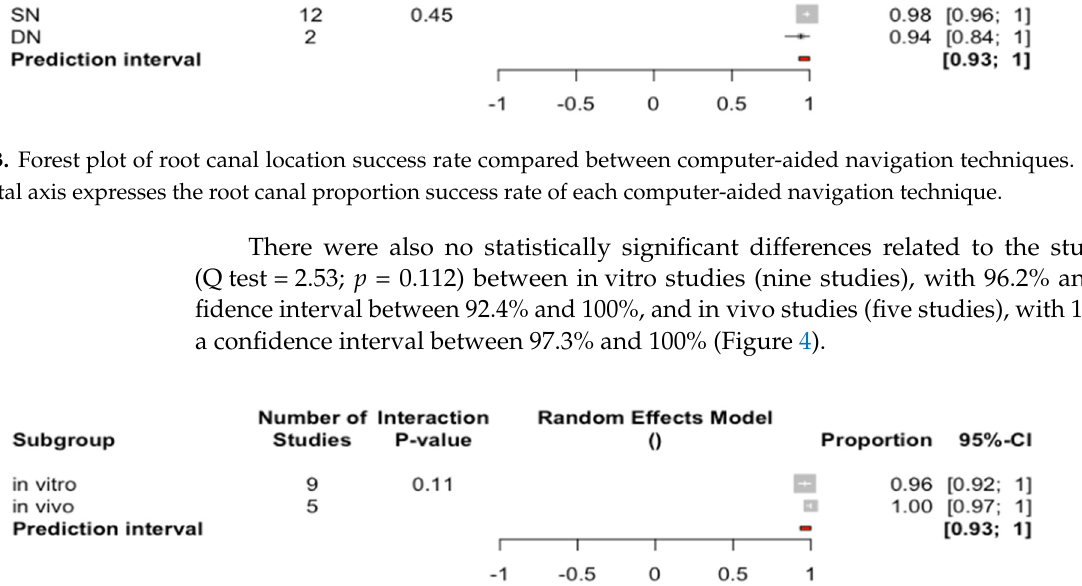
Figure 4. Forest plot of root canal location success rate between study types. The horizontal axis expresses the root canal proportion Scheme.